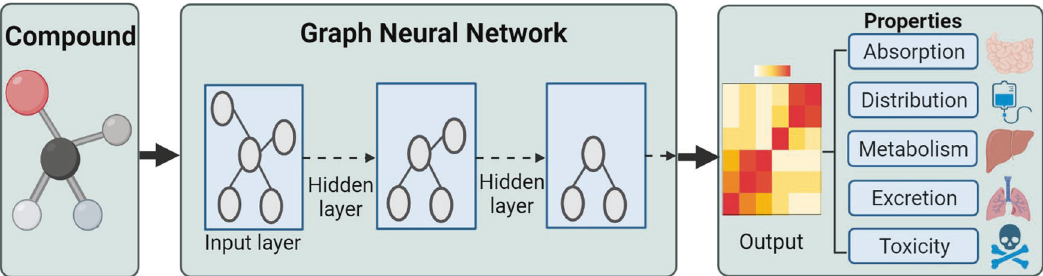
Fig. 12 The graph-based neural network capture the features related to drug properties from drug molecular structure to predict ADMET properties of drugs. (Created with